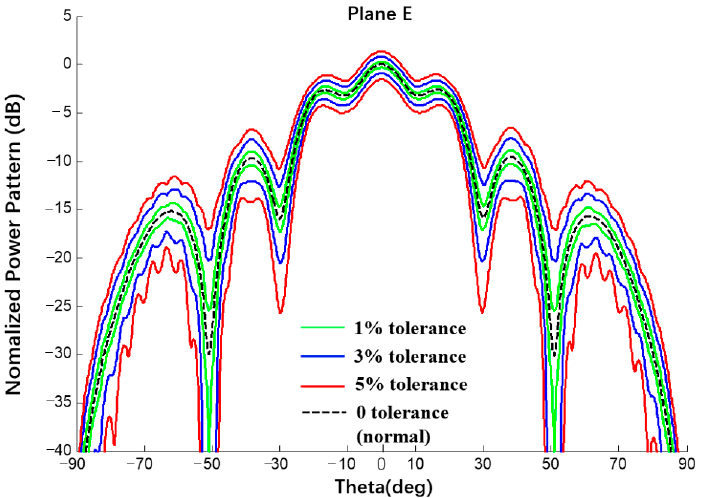
Figure 19. Interval power pattern of excitation amplitude error of spherical CAAs (Plane E, uniform excitation).